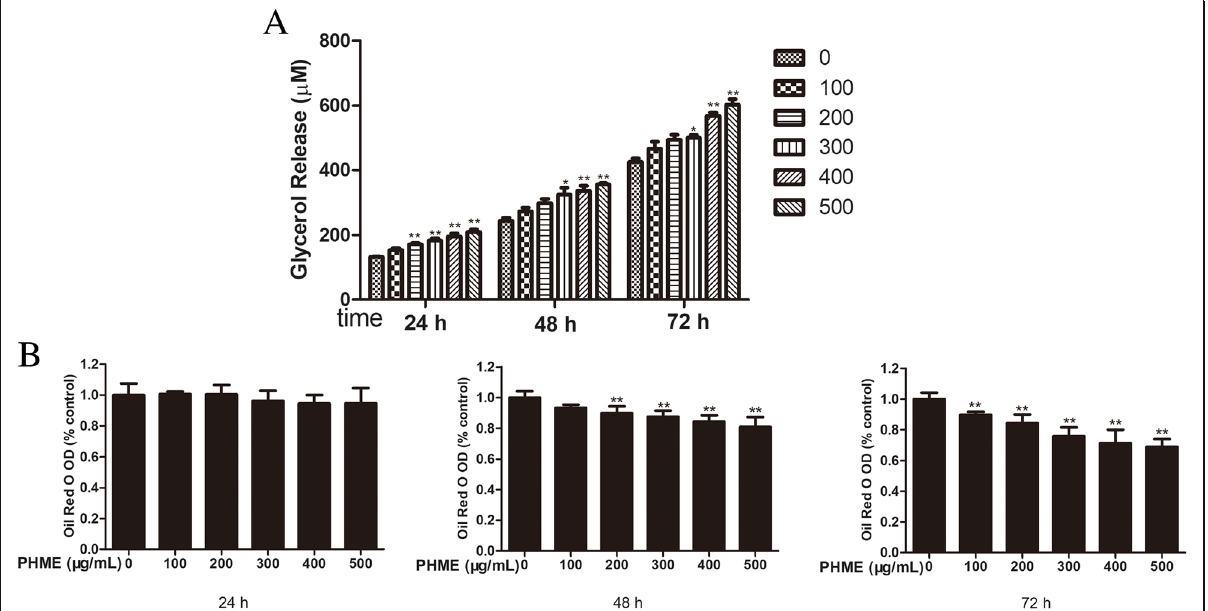
Fig. 2 Effect of PHME on adipocyte lipolysis. a Fully differentiated adipocytes treated with various concentrations of PHME (100, 200, 300, 400 and 500 μ g/mL) for 24, 48 and 72 h, respectively. Then, glycerol contents in media were measured by glycerol assay kit. b Adipocytes treated with PHME for 24, 48 and 72 h were stained with oil red O and quantified intracellular lipid by measuring the absorbance at 500 nm. Values are expressed as mean ± SD ( n = 4), * P < 0.05 and ** P < 0.01 vs. control group, respectively